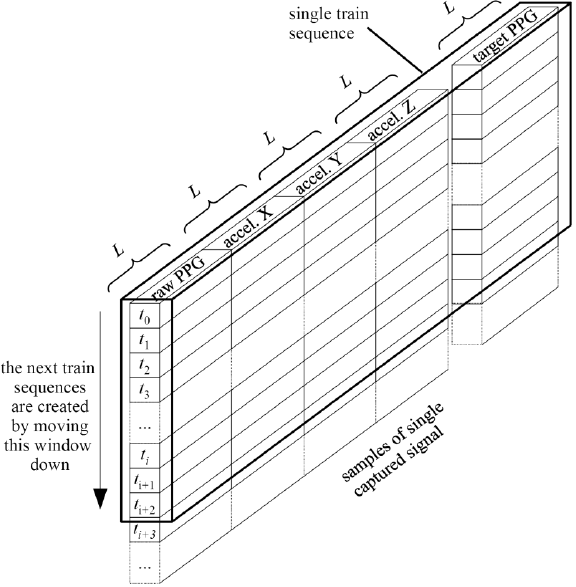
Figure 8. Overview of segmenting single captured signal and its ideal target into training sequence. The distance between samples used for the training sequence shown in the figure is S = 1.